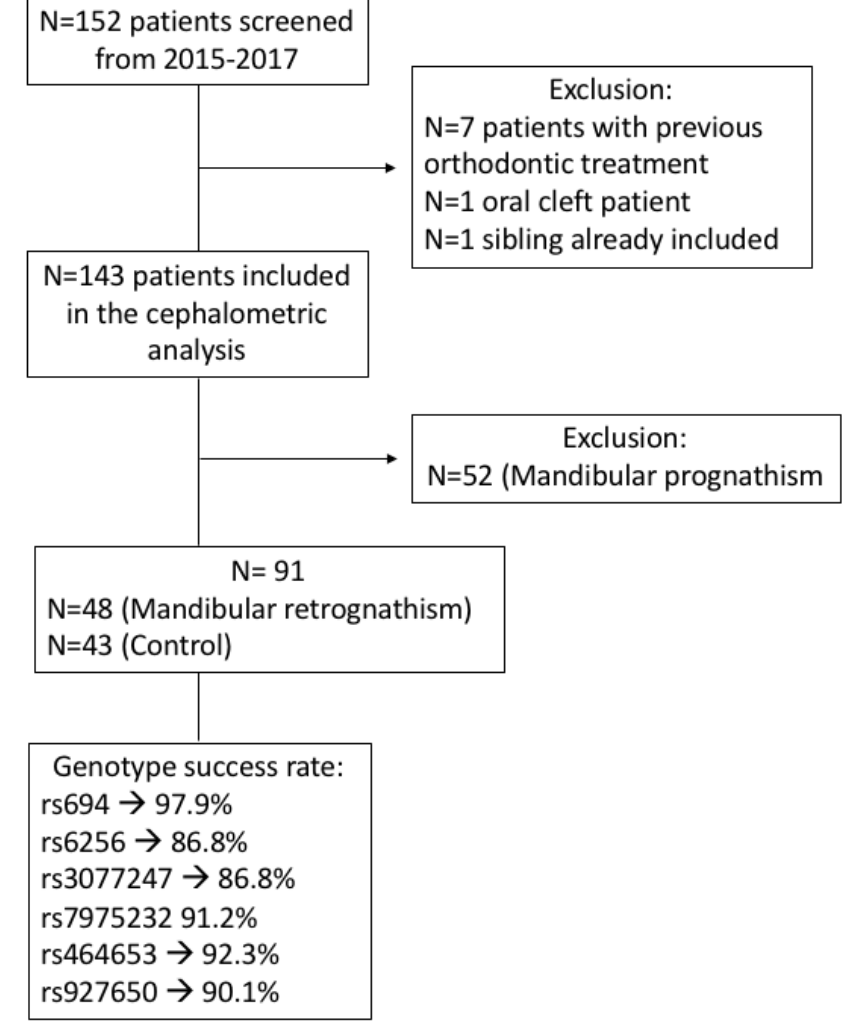
Figure 1. Flow chart of patient selection. Figure 2. Flow chart of patient